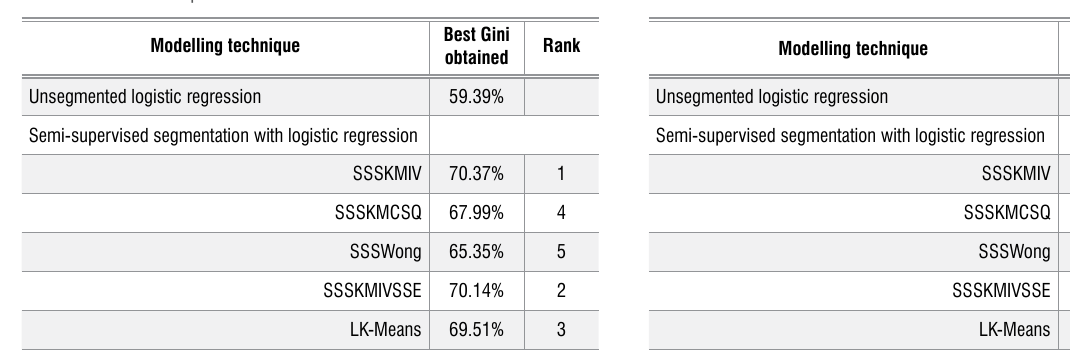
Protein tertiary structures data set: comparison of performance of techniques